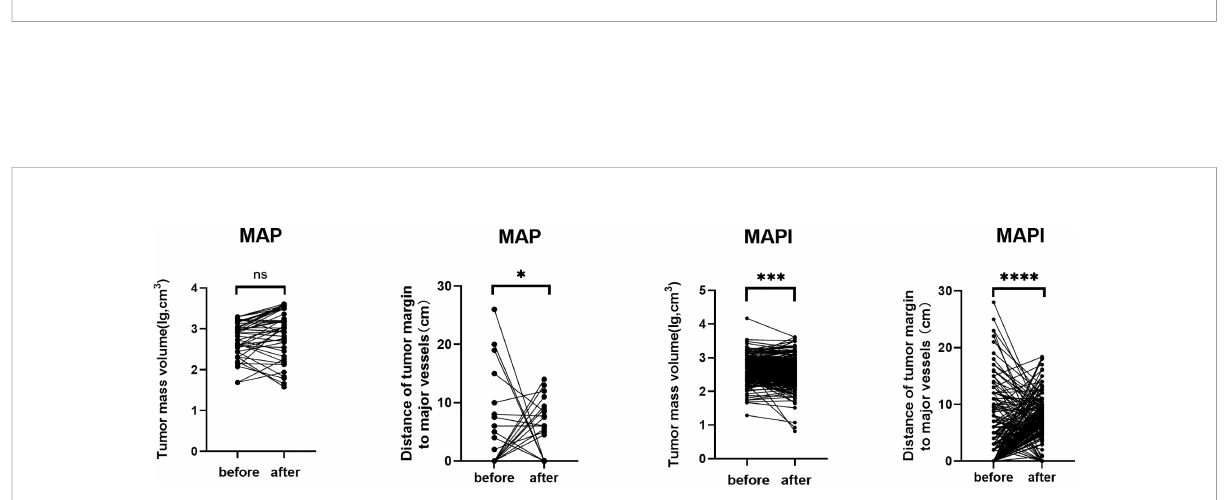
FIGURE 3 Schematic diagram of effects of IFO on the TMV and NBT after neoadjuvant chemotherapy.